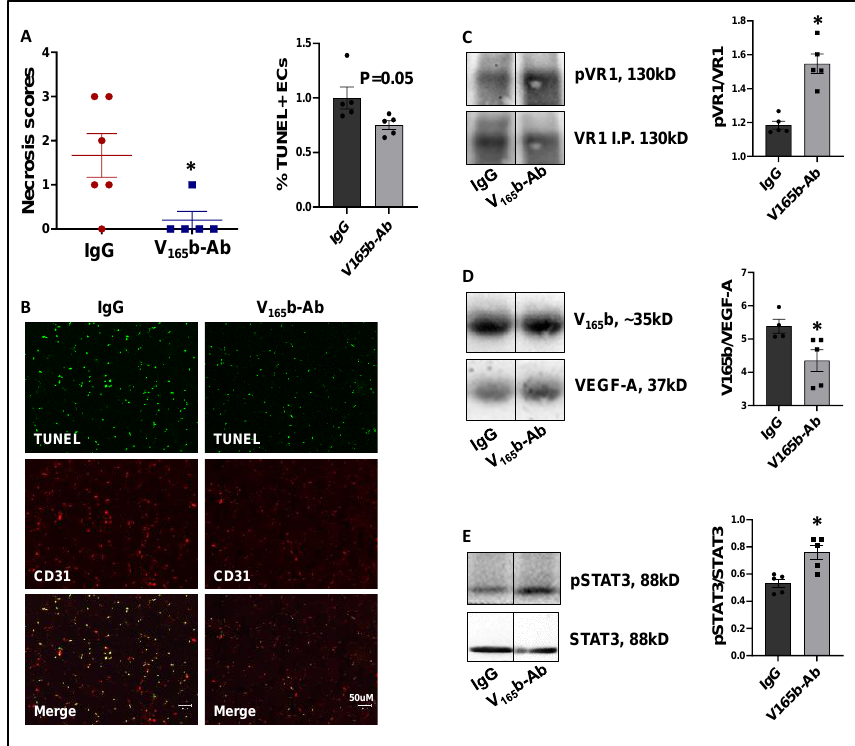
Figure 6. VEGF 165 b inhibition induces VEGFR1-STAT3 signaling and decreases necrosis in eNOS-KO mice in experimental PAD. ( A ) Necrosis scores in eNOS-KO mice ischemic muscle treated with IgG or VEGF 165 b-Ab. n ≥ 5, Non-Parametric Mann-Whitney test. ( B ) TUNEL (shown in green) and CD31 immunostaining (shown in red) to quantify endothelial apoptotic cell death in eNOS- KO mice ischemic muscle treated with IgG or V 165 b-Ab at day 3 post-HLI. n = 5. Unpaired t -test. ( C – E ) Immunoblot analysis of V 165 b, VEGF-A, and pVR1 in VEGFR1 pull-down fractions (VR1-IP); pSTAT3/STAT3 in eNOS-KO mice ischemic muscle treated with IgG or V 165 b-Ab at day 3 post-HLI. n ≥ 5. Unpaired t -test. * p < 0.05 considered significant. Data Mean ± SEM. Laser Doppler showed that VEGF 165 b-Ab in Mg-Tg ischemic muscle significantly en- hanced perfusion recovery (d7: IgG-17.3 ± 1.7 vs. V 165 b-Ab-34.0 ± 2.1; d14: IgG-44.6 ± 2.9 vs. V 165 b-Ab-74.4 ± 2.5; d21: IgG-68.6 ± 2.7 vs. V 165 b-Ab-89.1 ± 3.1; d28: IgG-74.8 ± 2.1 vs. V 165 b-Ab-95.6 ± 3.5) vs. IgG (Figure 7A). The immunohistochemistry of CD31